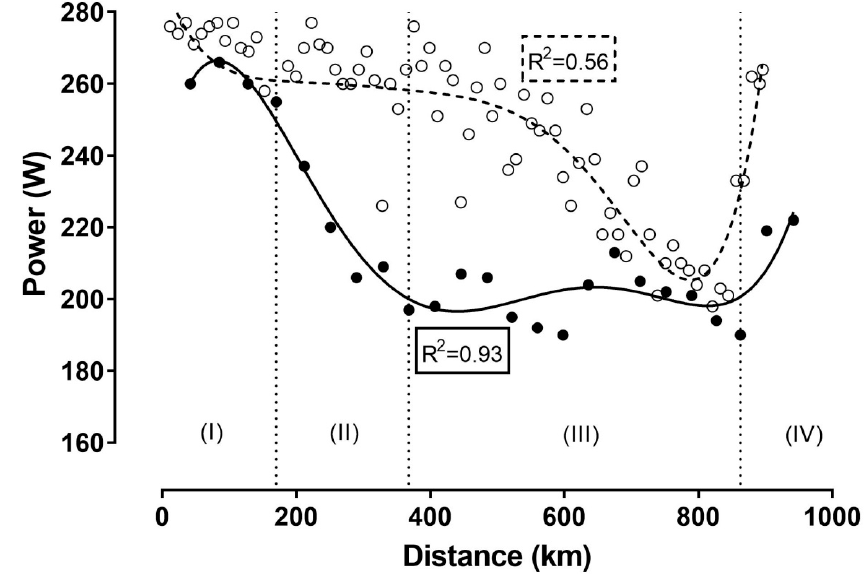
Figure 2. Power output (W) during the record attempt. Latin numbers (I, II, III, IV) denote the phases of the race, which are separated by vertical dashed lines. The present record attempt (track cycling) is presented by (cid:8) , whereas the previous attempt (road cycling) is represented by . R 2 estimates the goodness of fit.